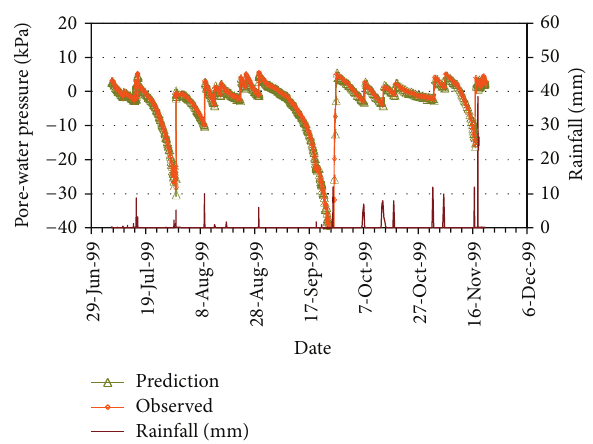
Figure 8: Comparison between observed and predicted pore-water pressures obtained using the ANN model.